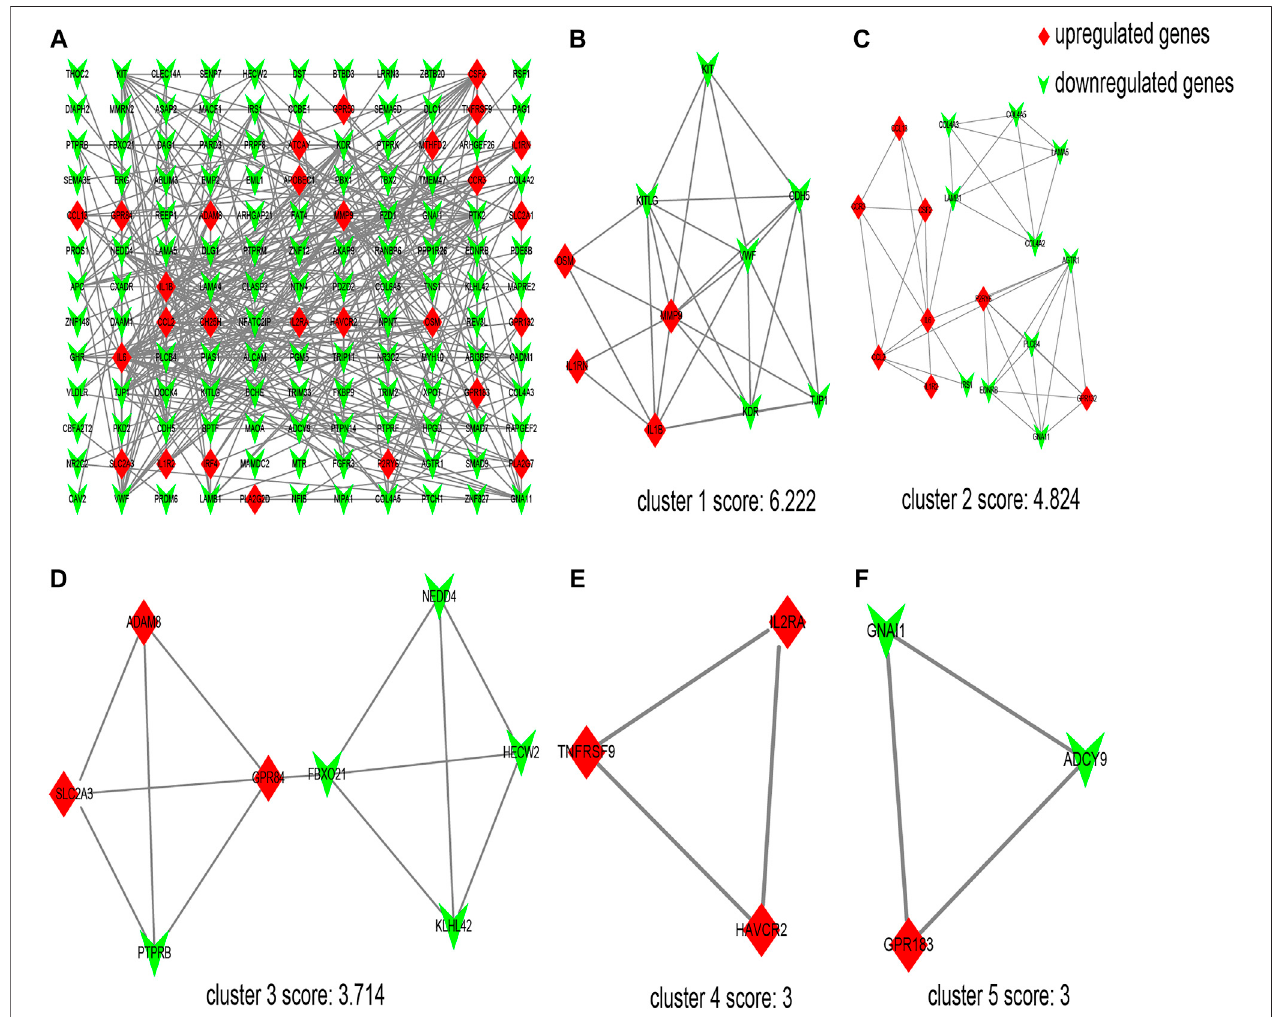
FIGURE 2 | Protein – protein interaction (PPI) network of differentially expressed genes (DEGs) and fi ve cluster modules extracted by MCODE. (A) The interaction network between proteins coded by DEGs comprised 144 nodes and 355 edges. Red diamonds represent the upregulated genes, and green V represents the downregulatedgenes.FiveclustermodulesextractedbyMCODE.Cluster1 (B) hadthehighestclusterscore(score:6.222,10nodesand28edges),followedbycluster 2 (C) (score: 4.824, 18 nodes and 41 edges), cluster 3 (D) (score: 3.714, 8 nodes and 13 edges), cluster 4 (E) (score: 3, 3 nodes and 3 edges), and cluster 5 (F) (score: 3, 3 nodes and 3